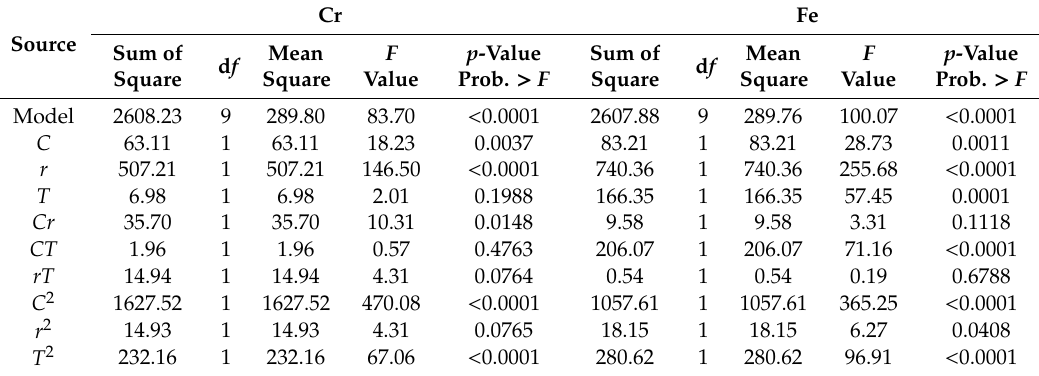
Table 3. ANOVA for response surface methodology (RSM) quadratic models developed.